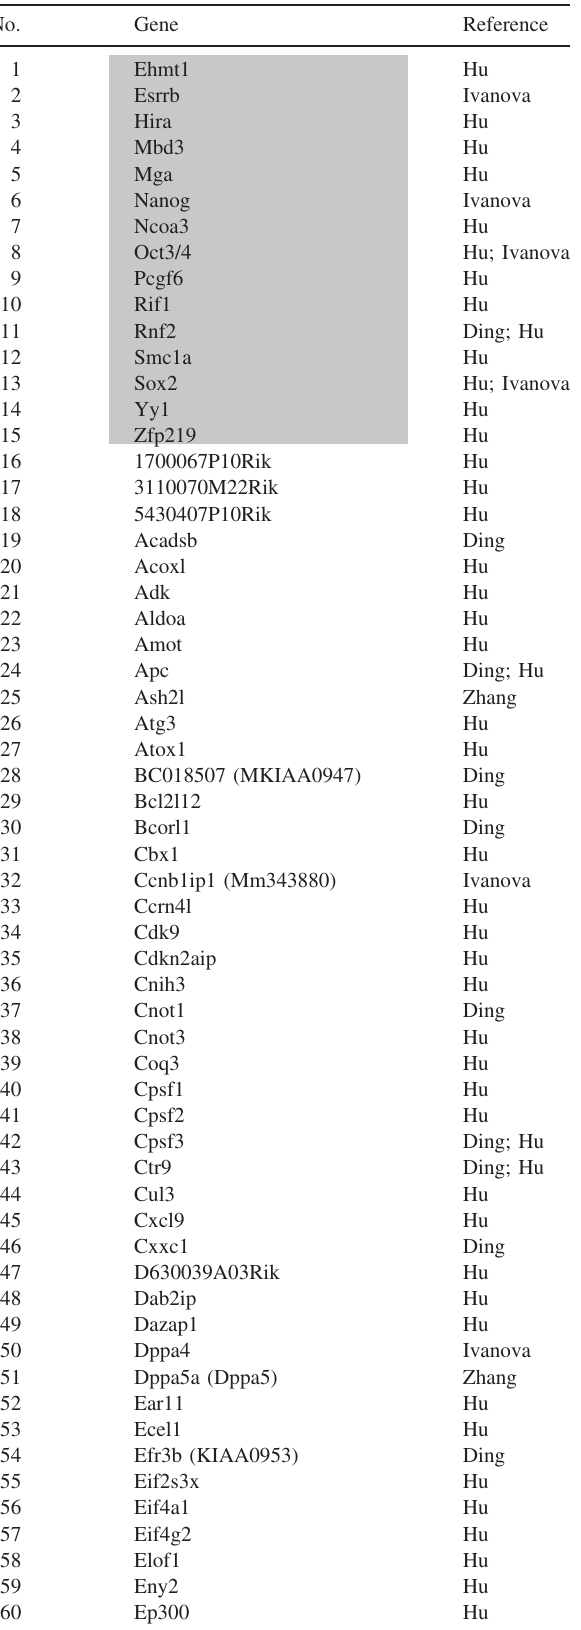
Table 1 Pluripotency-associated genes found via RNAi